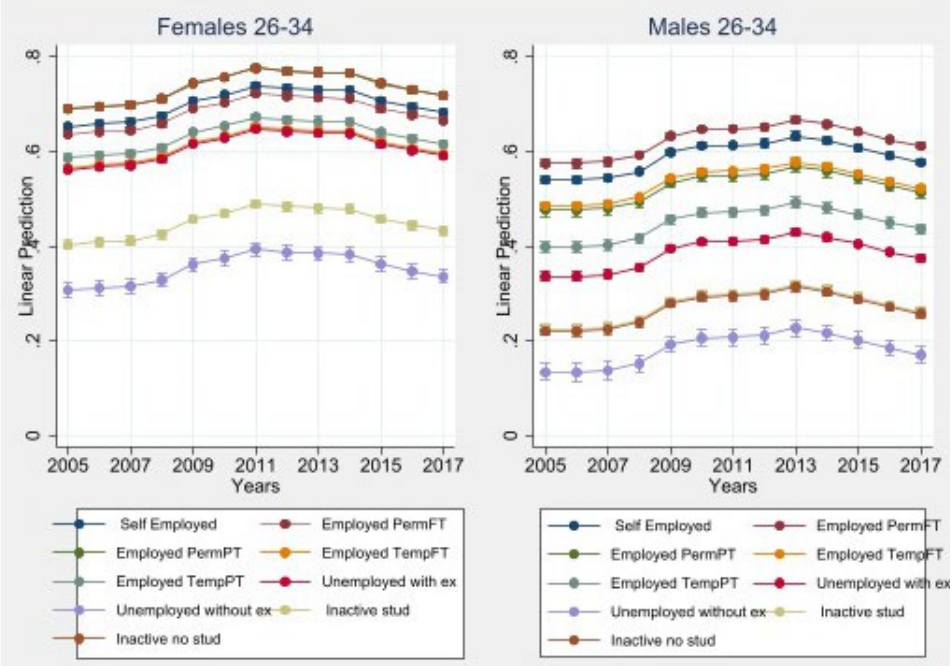
Figure 8 : Predicted probability of youth between 26-34 years of age living out of the parental home by gender and other household members’ employment deprivation situation.